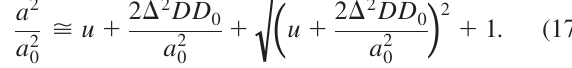
ffiffiffiffiffiffiffiffiffiffiffiffiffiffi p u 2 þ 1 Þ , which is